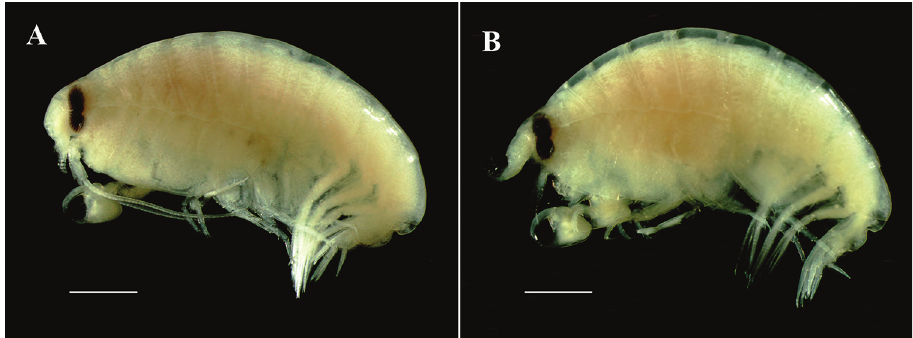
Figure 5. Opisa takafuminakanoi Narahara-Nakano, Kakui & Tomikawa, 2016 A adult male, NI- BRIV0000880624, 8.8 mm, habitus B adult female, NIBRIV0000880625, 8.7 mm, habitus. Scale bars: 1.0 mm ( A, B